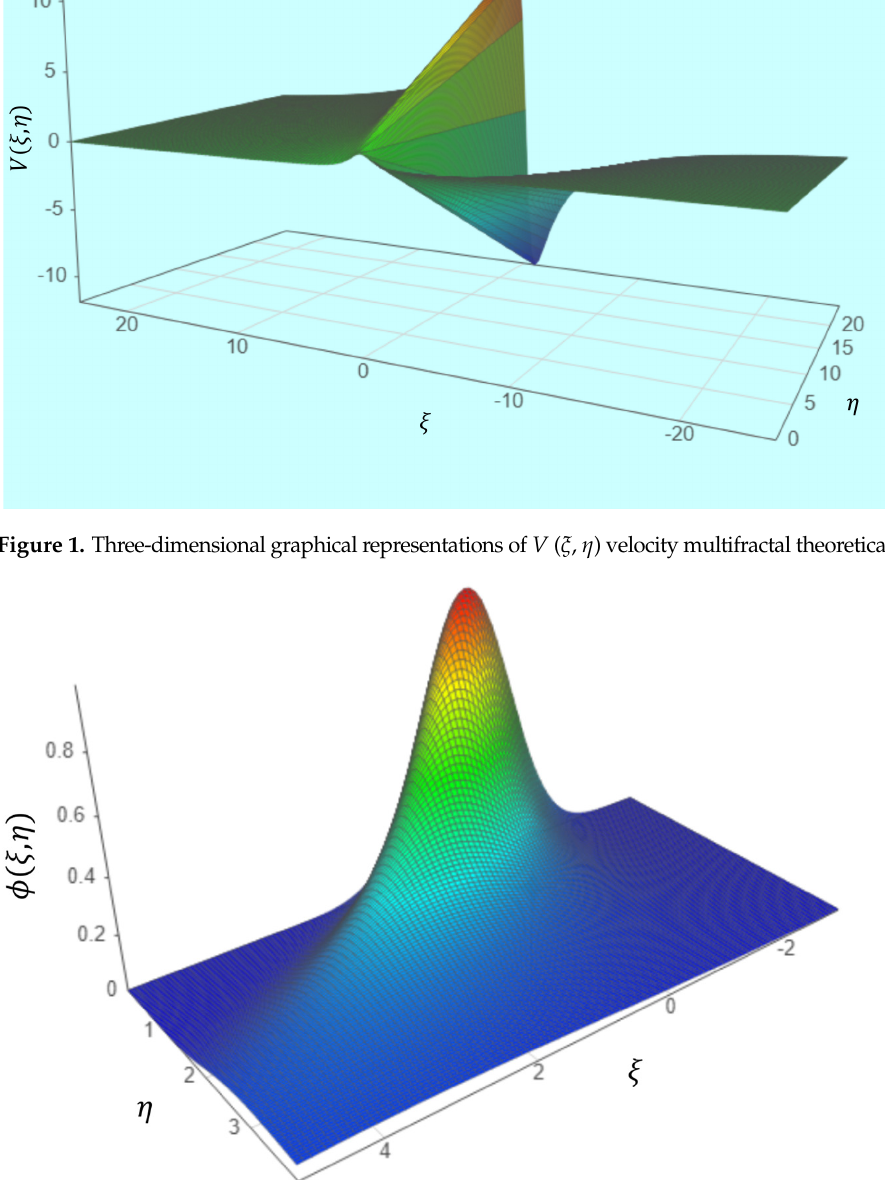
Figure 2. Three-dimensionalgraphicalrepresentationofthe φ = φ ( ξ , η Figure 2. Three ‐ dimensional graphical representation of the ϕ = ϕ ( ξ , η ) mass state density theoretical function.